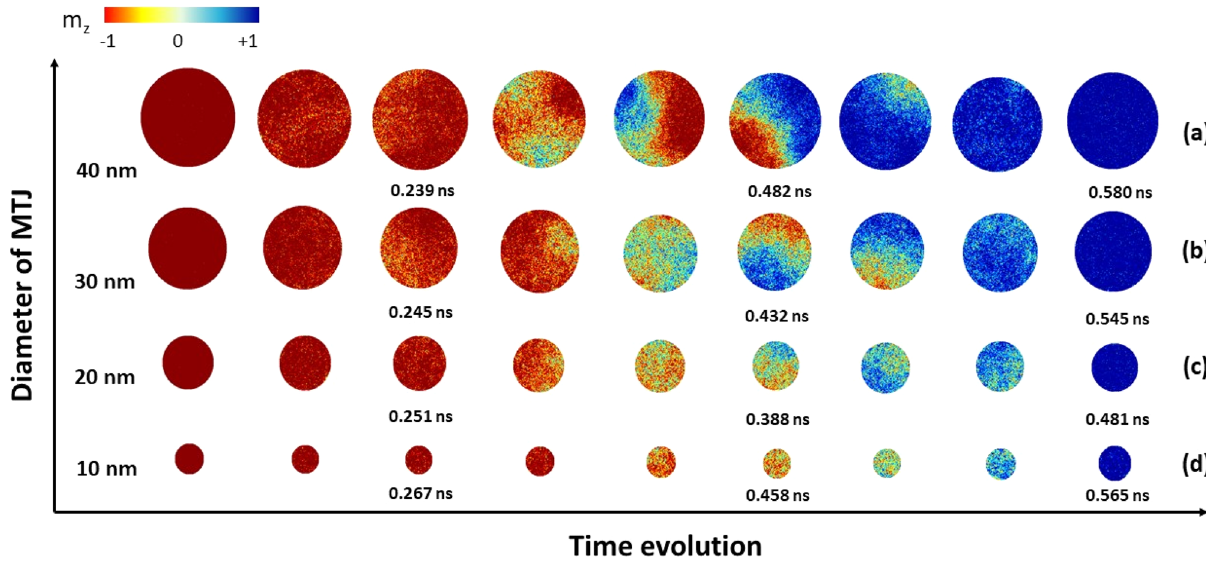
Figure 7. The time evolution of the out-of-plane ( z -) component of the FL magnetization in MTJs with different diameters at 300 K for a injected current density of 5 MA/cm 2